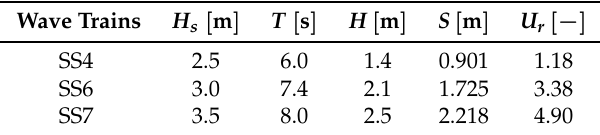
Table 3. The wave trains simulated.